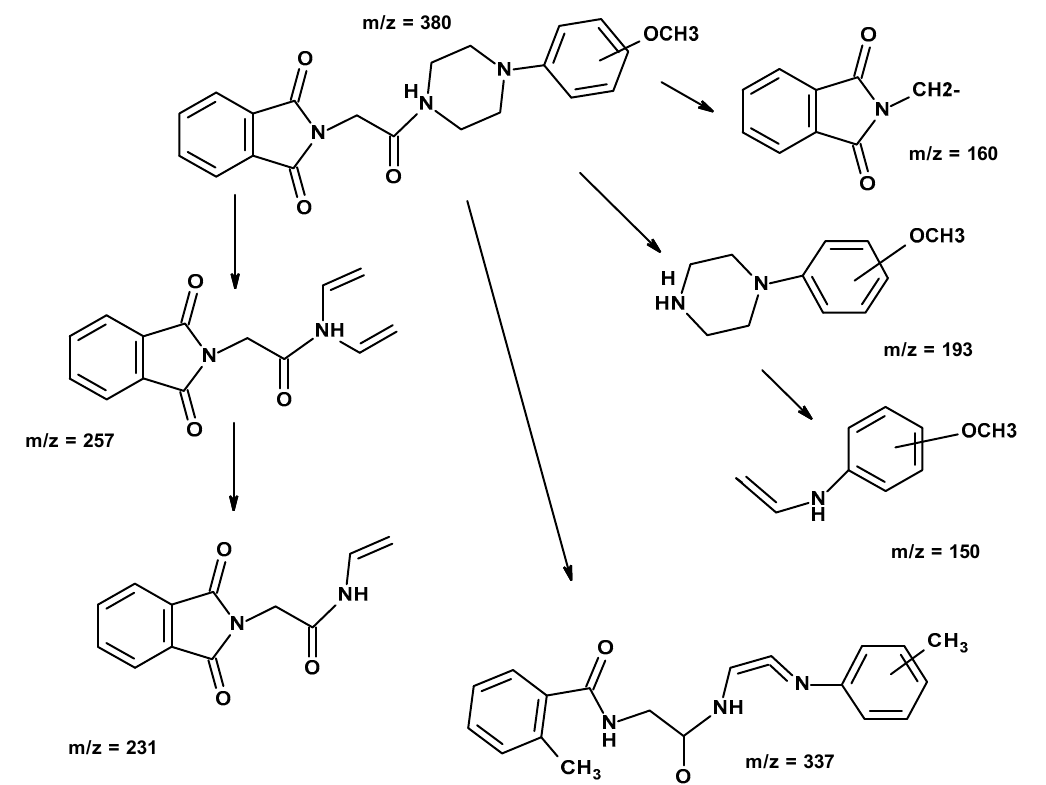
Scheme 6. The probable mechanism of G, H, and I degradation in methanol solution, proposed based on ESI–MS.